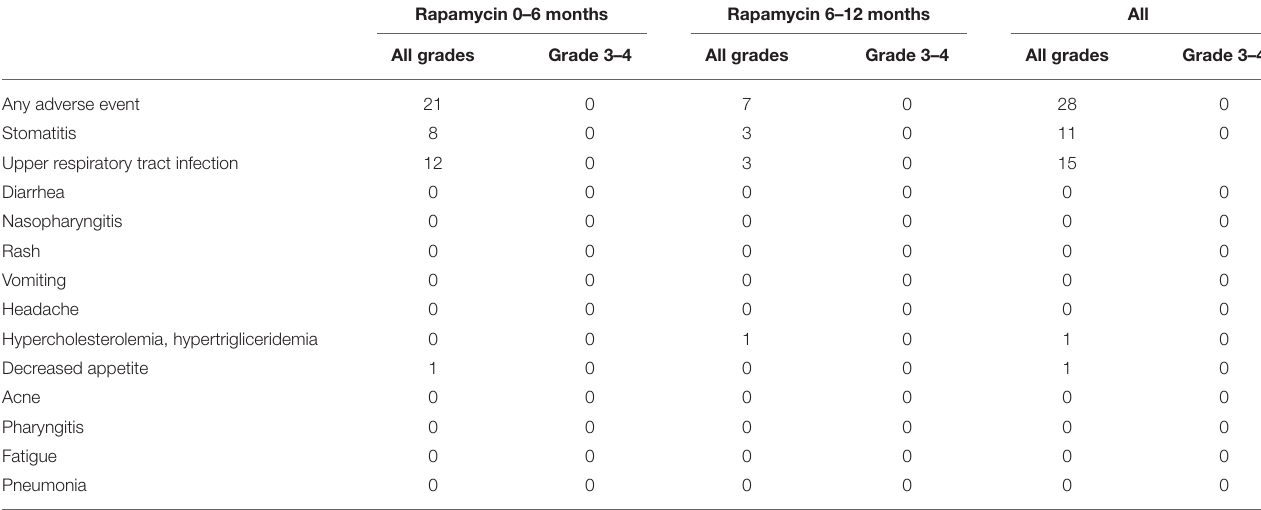
TABLE 2 | Adverse events of any cause reported during the rapamycin